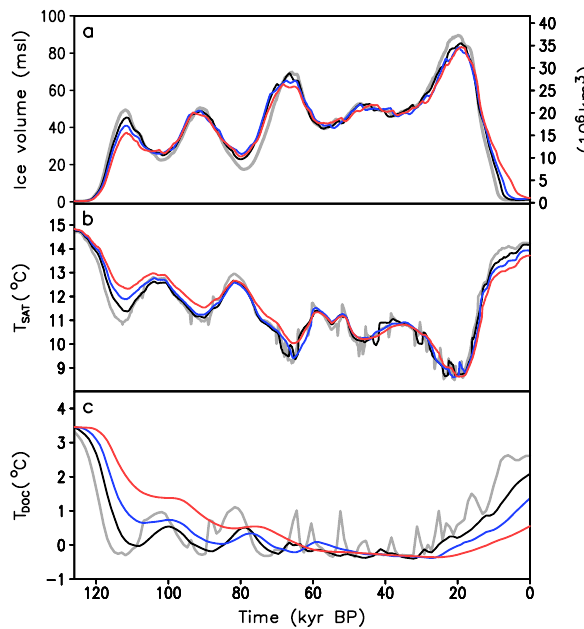
Fig. 12. Effect of acceleration of the climate component on simu- lated (a) NH ice volume, (b) global annual mean surface air temper- ature and (c) globally averaged deep ocean (4km) temperature. The grey lines in all figures show the Baseline Experiment. The black, blue and red lines indicate experiments with an acceleration by a factor of 5, 10 and 20,